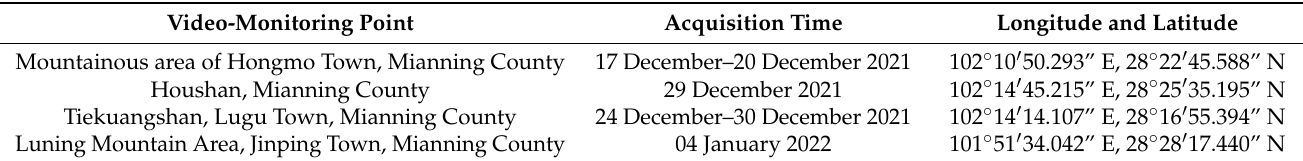
Table 3. Video-monitoring area information.